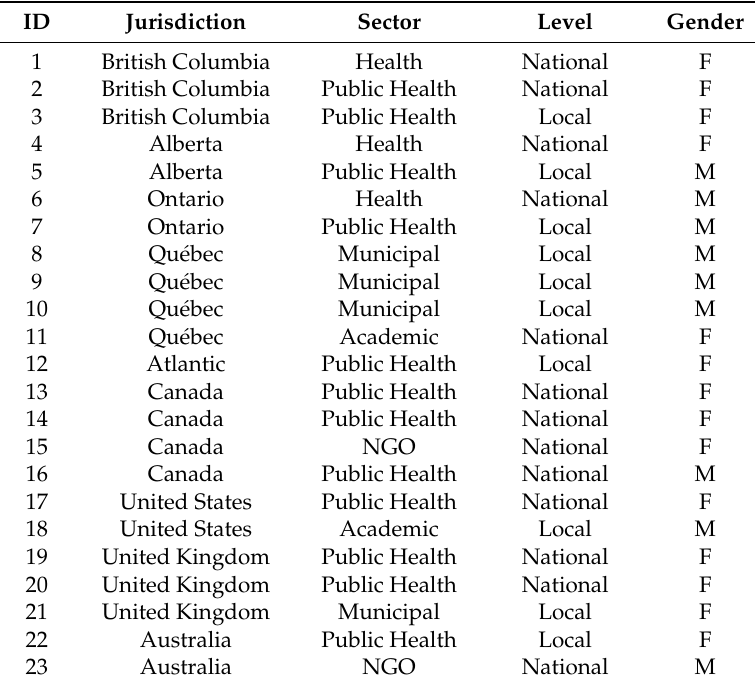
Table 1. Profiles of KIs interviewed in this